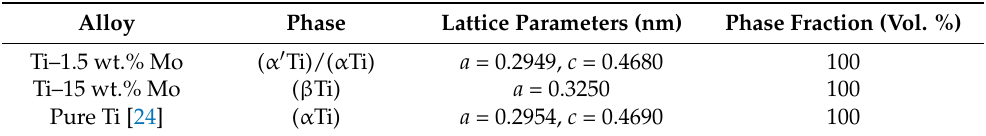
Table 1. Phase composition, lattice parameters, and phase fraction for Ti–1.5 wt.% Mo and Ti–15 wt.% Mo alloys annealed at 1000 °C for 24 h.